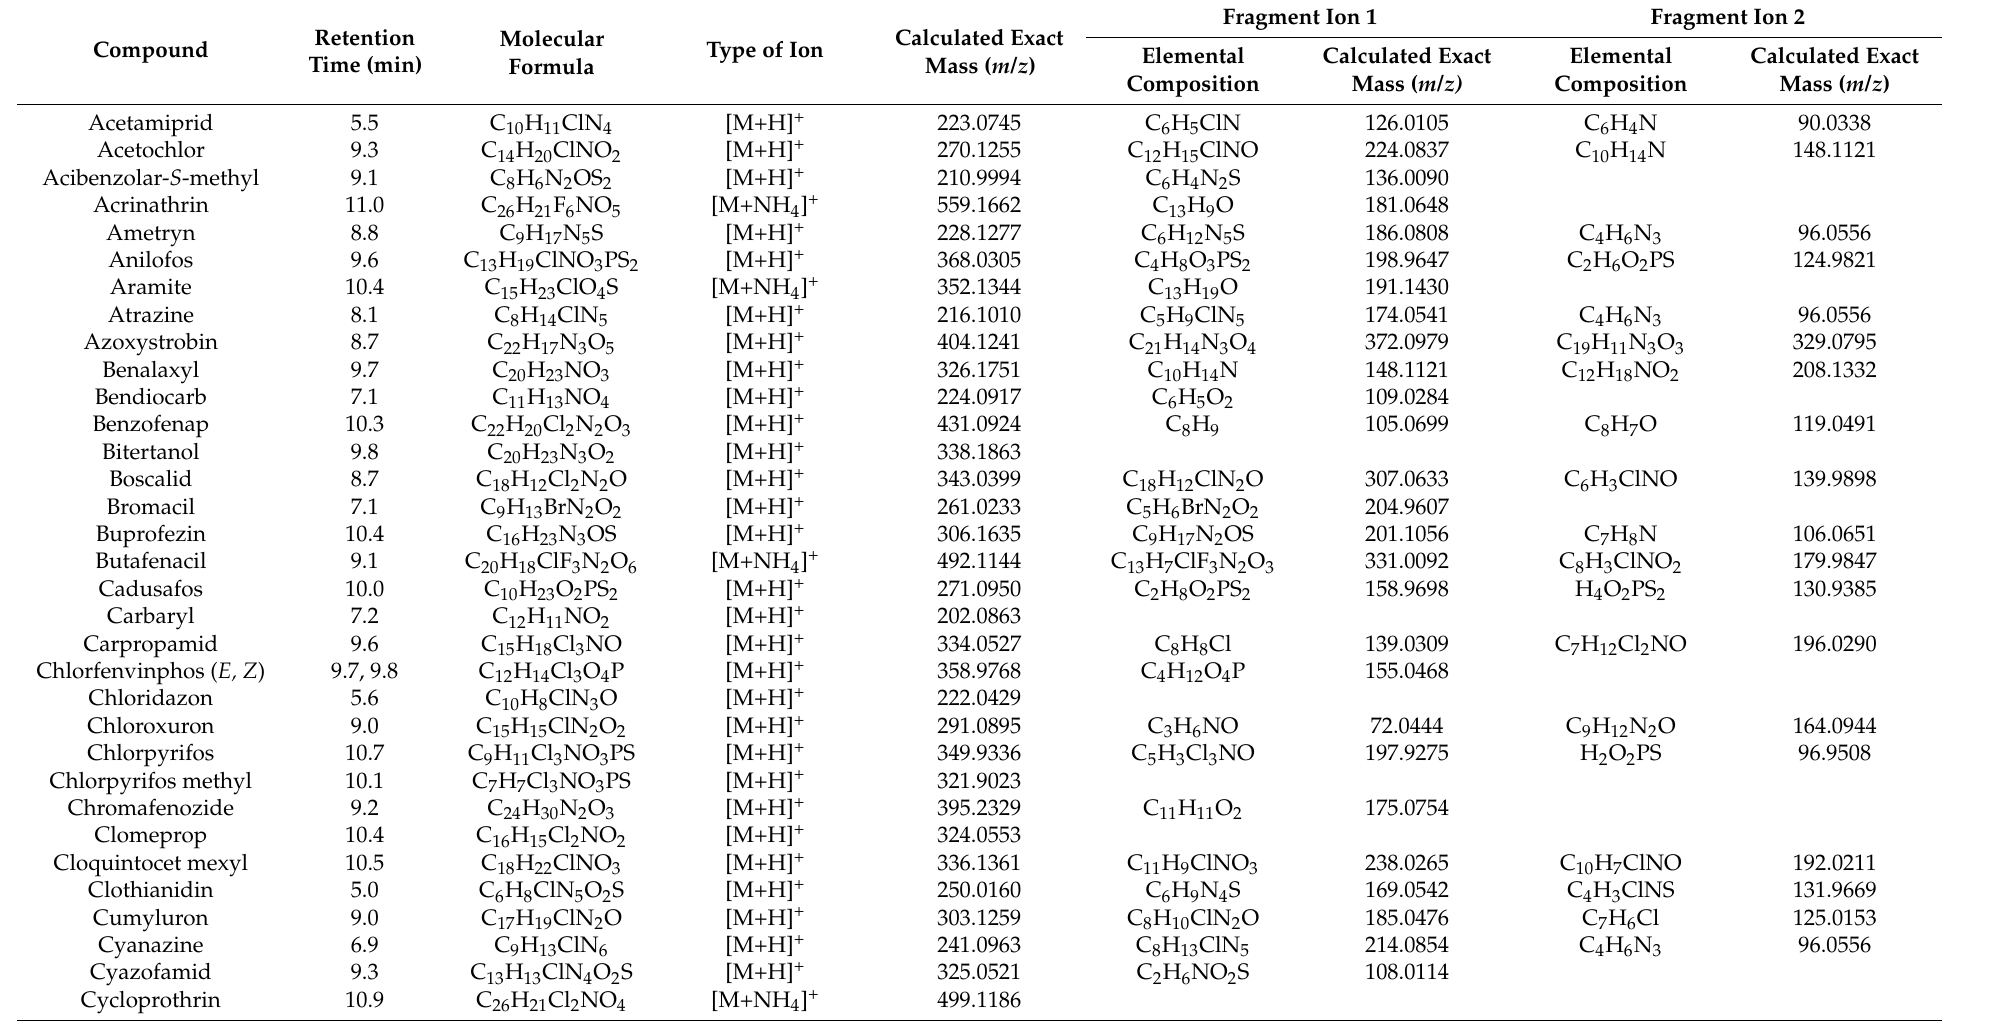
Table 1. Elemental composition, retention time, and calculated exact mass of the target